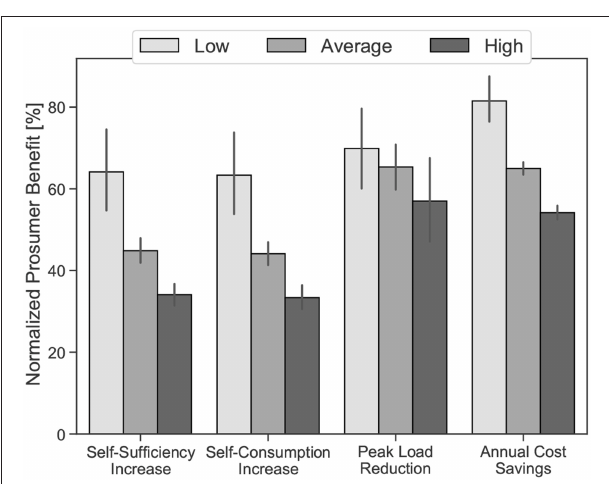
FIGURE 10 | Comparison between different consumption behavior at the prosumer level. FIGURE 11 | Benefits of different prosumers based on the fixed load